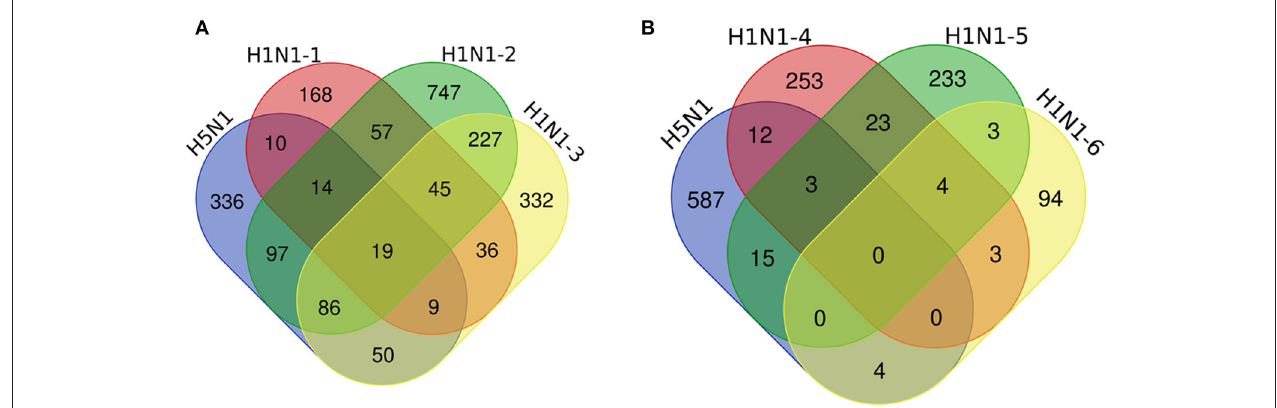
FIGURE 3 | Comparative analysis of the host proteins that interact with H5N1 AIV and H1N1 influenza viruses. Venn diagrams illustrate the overlap of the host interacting proteins between our data and other IAV-related datasets, including previously published H1N1 IAV–human PPIs (A) and host proteins implicated in H1N1 IAV function by an RNA interference (RNAi) screen (B) . H5N1 indicates our data, A/mallard/Huadong/S/2005 (SY), chicken DF1 cells; H1N1-1, influenza A/Puerto Rico/8/34, human HEK293 cells; H1N1-2, A/WSN/33, human HEK293 cells; H1N1-3, A/Puerto Rico/8/1934, human A549 cells; H1N1-4, WSN-Ren, human A549 cells; and H1N1-5 and H1N1-6, A/WSN/33, human A549